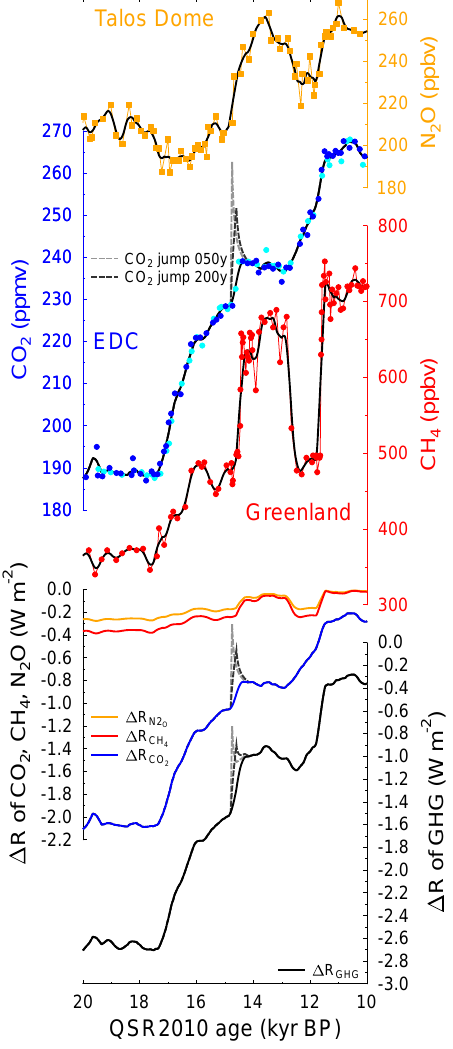
Fig. 8. Greenhouse gas records (Talos Dome N 2 O, EDC CO 2 , Greenland composite CH 4 ) and their radiative forcing 1R during Termination I. See Captions to Fig. 1b for details. EDC CO 2 and Greenland composite CH 4 are plotted on the QSR2010 age scale, thus without considering a potential dating artefact in EDC CO 2 due to CH 4 synchronisation, Talos Dome N 2 O is shown on the TALDICE-1 age scale. Black lines are running means over 290yr (to reduce sampling noise) of resamplings with 10yr equidistant spacing. Talos Dome and Greenland gas records are temporally higher resolved than EDC and should contain a much smaller effect of the age distribution PDF proposed for CO 2 in EDC. The two CO 2 jump scenarios are the minimum and maximum injection scenar- ios from our BICYCLE simulations which are still in line with the in-situ CO 2 data in EDC. The 50-yr and 200-yr injection scenario contains a constant injection flux of either 2.5 and 0.625 PgCyr − 1 , respectively, over the given time window. The calculated radiative forcing 1R uses equations summarised in K¨ohler et al. (2010a) in- cluding a 40% enhancement of the effect of methane (Hansen et al.,